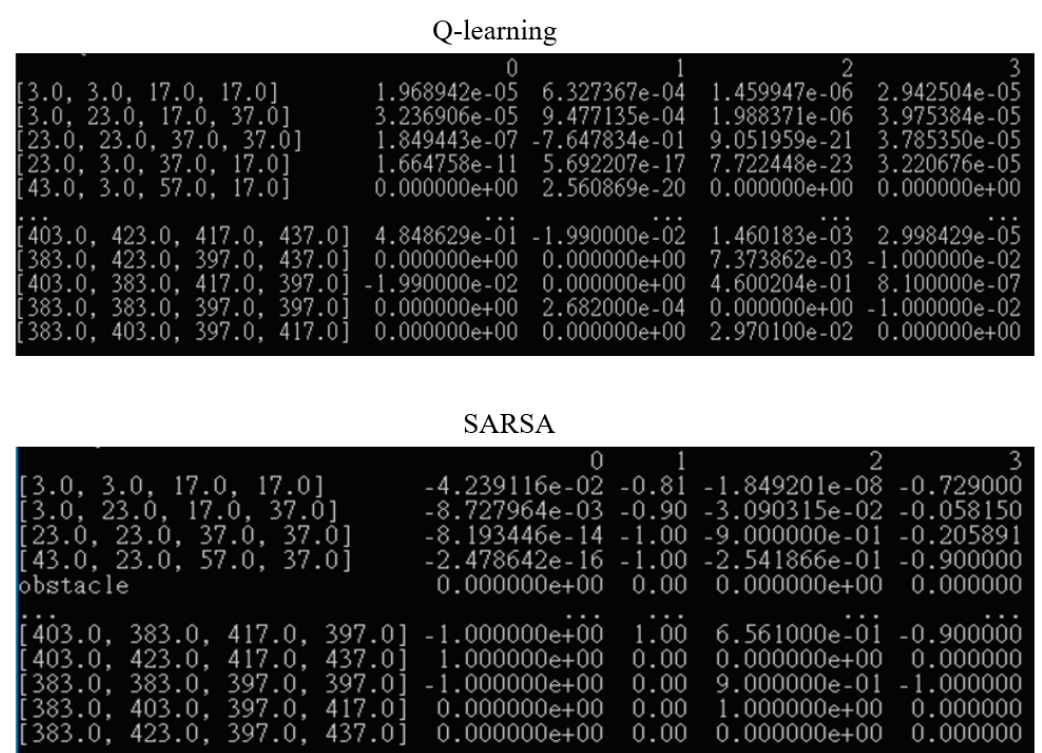
Figure 27. The Q-table for Q-learning and SARSA in Environment 1. Table 2. The results compared for Environment 1.